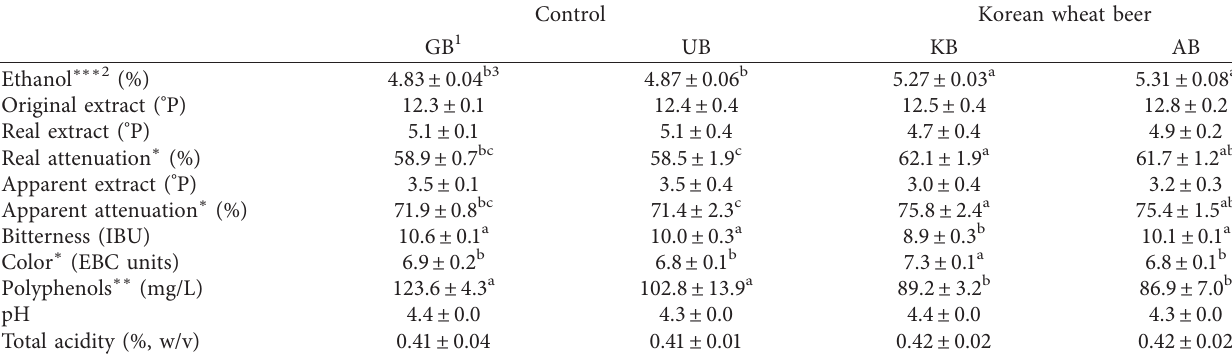
Table 2: Physicochemical characteristics of wheat